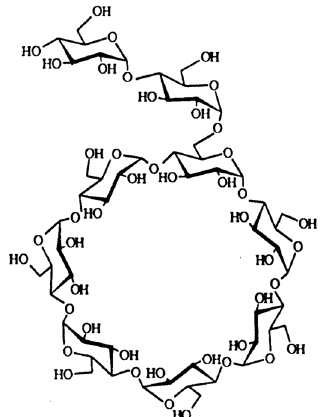
Figure 1. Chemical structure of G2- β -CD.